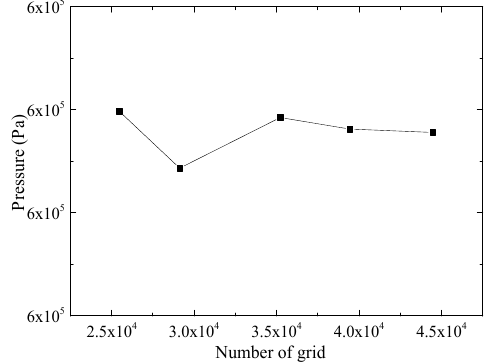
Figure 5. Validation of mesh independence.